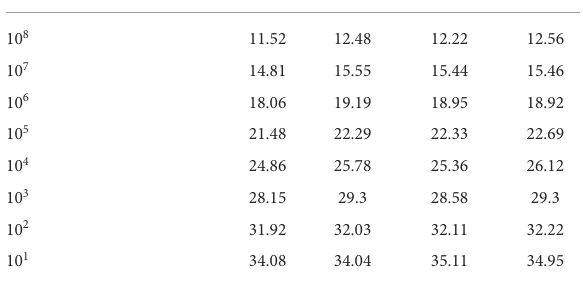
TABLE 2 The quantification cycle (Cq) values of the single qPCR assays for individual viruses. Templates (copies/ µ